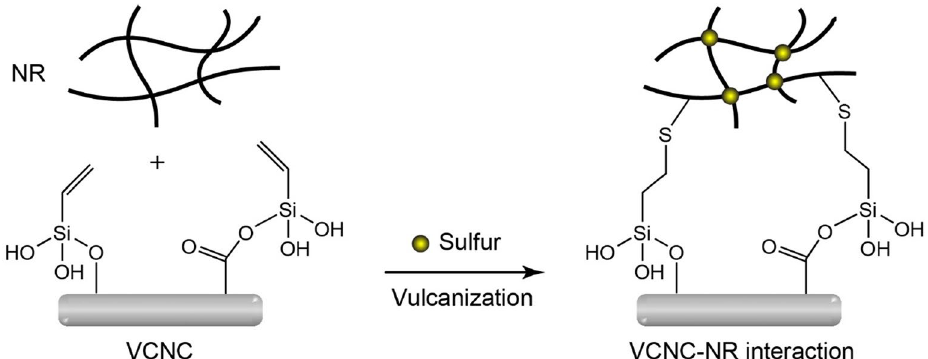
Figure 12. Proposed interaction between VCNC and